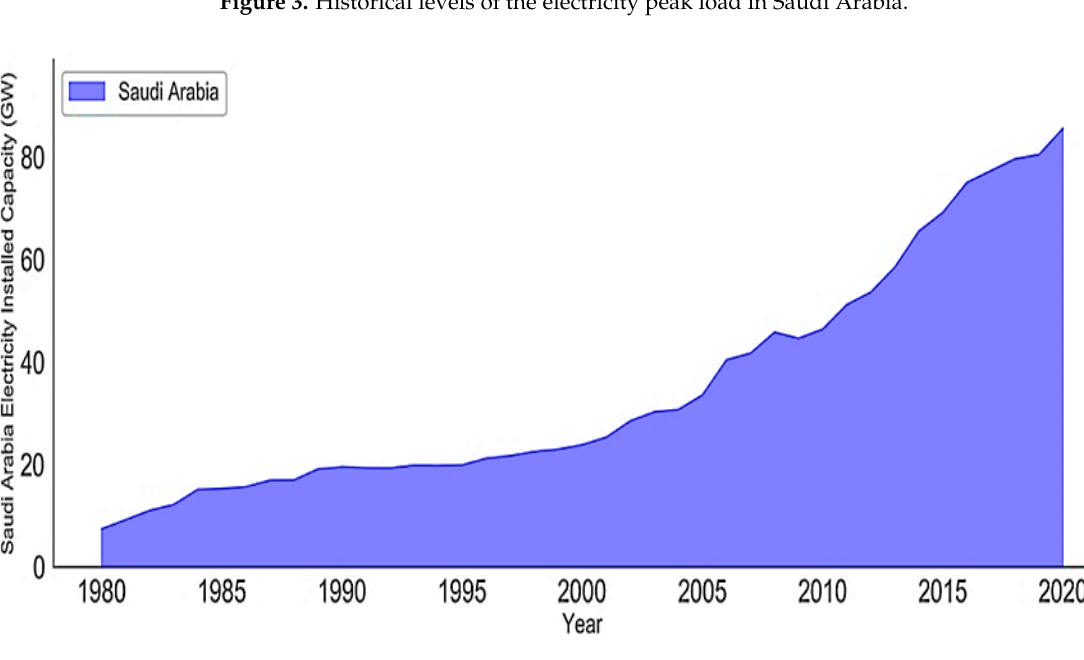
Figure 3. Historical levels of the electricity peak load in Saudi Arabia.